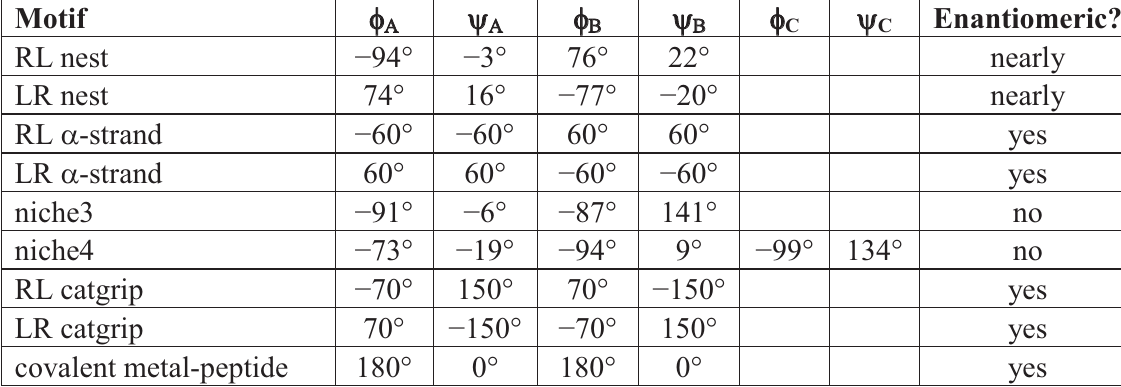
Table 1. Many three-residue motifs are specified by two pairs of (cid:5)(cid:7)(cid:6) angles for two successive amino acids. When its main chain atoms are enantiomeric ( (cid:5) (cid:8)(cid:9) (cid:10)(cid:9)(cid:11)(cid:5) (cid:12)(cid:9)(cid:9) and (cid:10)(cid:9)(cid:11)(cid:6) (cid:13)(cid:9)(cid:9) a dipeptide is said to be enantiomeric and may occur as part of a longer (cid:9)(cid:6) (cid:8)(cid:9) (cid:12) enantiomeric peptide. The niche4 is a four-residue motif specified by three pairs of angles. In proteins glycines are common (50 – 80%) at residues where (cid:5)(cid:9)(cid:14)(cid:9)(cid:15) °